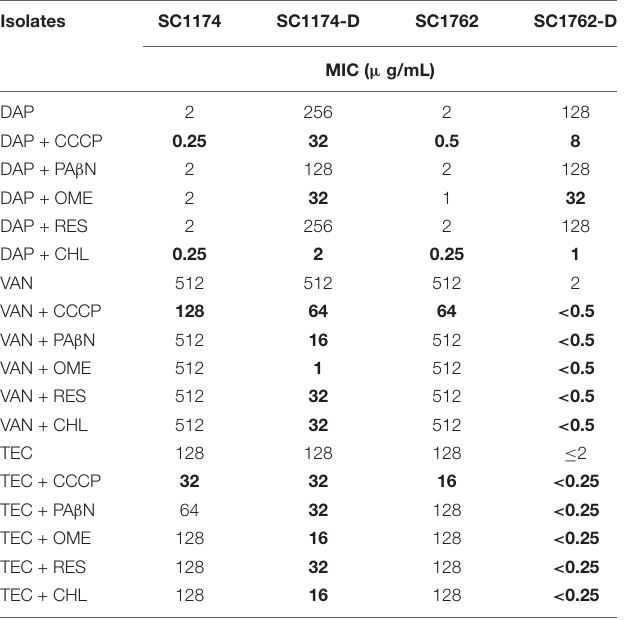
TABLE 2 | Efflux pump phenotype testing.